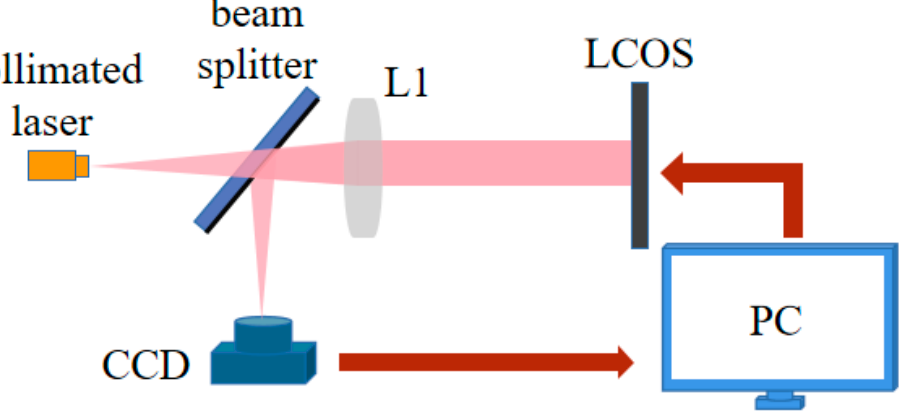
Figure 8. Experimental setup for the online spot array generation.